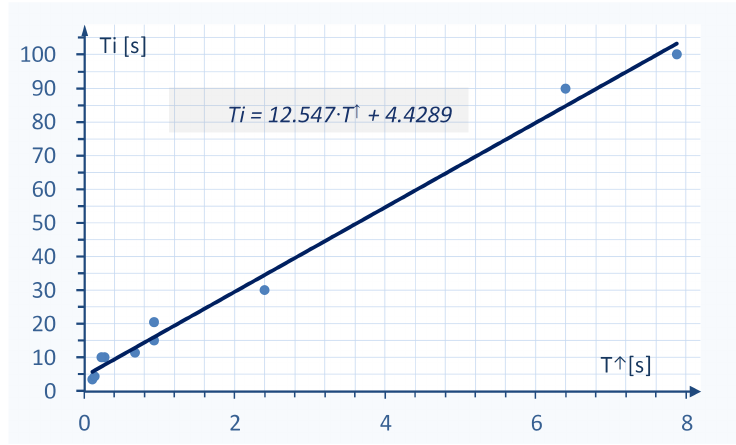
Figure 12. The integral time, T i , versus the effective time constant, T ↑ .